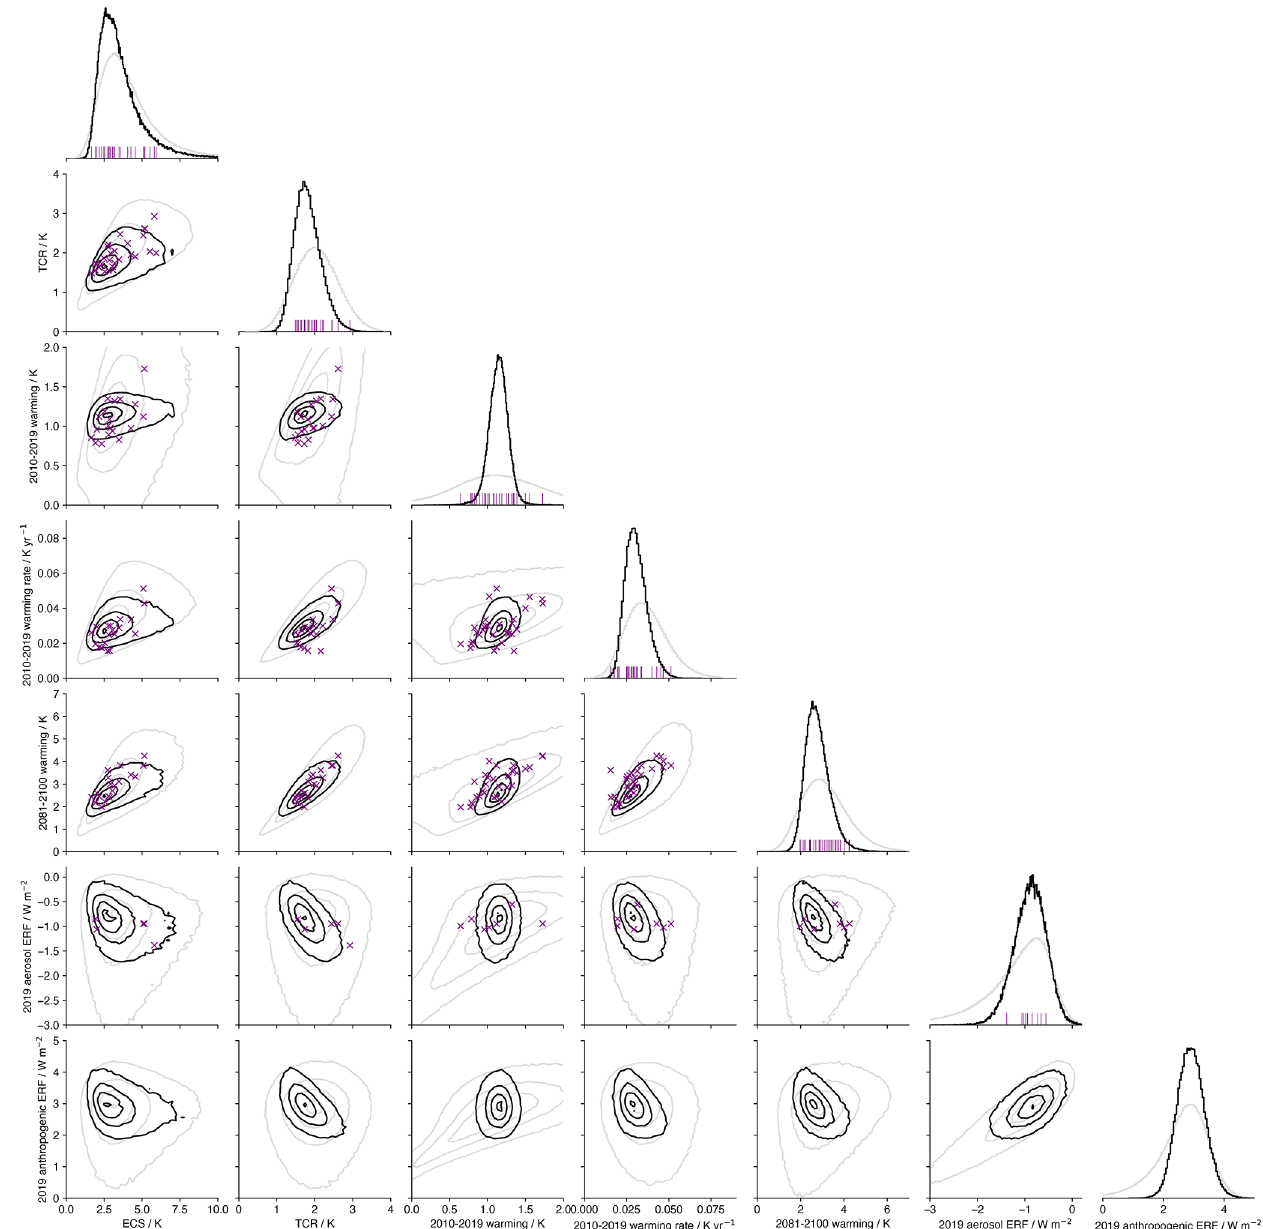
Figure 7. Corner plot of key quantities within the full and constrained ensembles, based on following a historical trajectory to 2014 and SSP2-45 thereafter. Diagonal plots show marginal probability density functions of each key variable: full is shown in grey, and constrained is shown in black. Sub-diagonal plots show contour plots of joint probability density function. Contours shown indicate normalized likelihoods of 5%, 33%, 66%, and 95%. Purple crosses and lines indicate the positions of individual CMIP6 models. The 2010–2019 warming rate for CMIP6 models is calculated as the slope of a linear regression over 2000–2029 due to internal variability projecting strongly on the slope estimate and error if a shorter period is